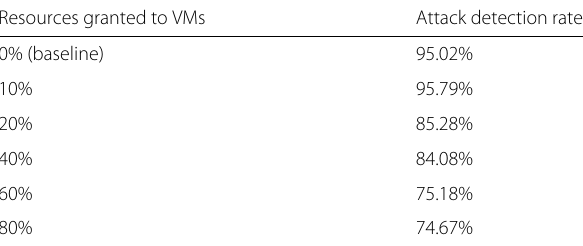
Table 2 Attack detection rates when granting resources (CPU, Memory, I/O and Network) to